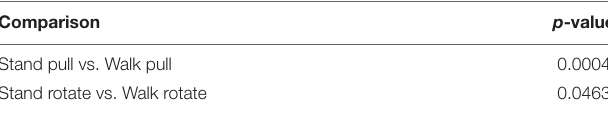
TABLE 1 | Comparison of the fractal dimension of EEG signals between walking and standing in case of pulling and rotating. Comparison p -value Stand pull vs. Walk pull